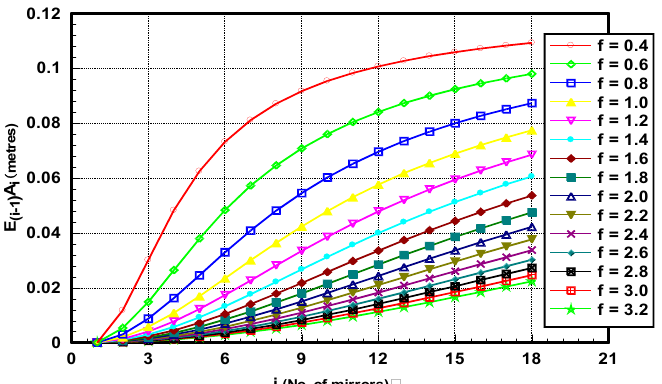
Figure 5. Non-useful collector area plotted against number of mirrors with Different focus distances of concentrator aperture.